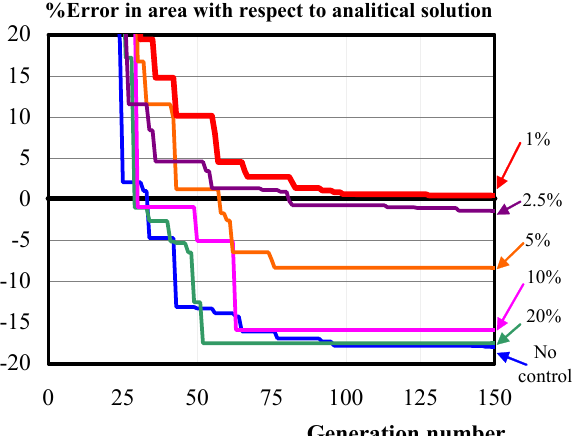
Fig. 6. Influence of γ over the accuracy of the objective function and the degree of satisfaction of stress constraint